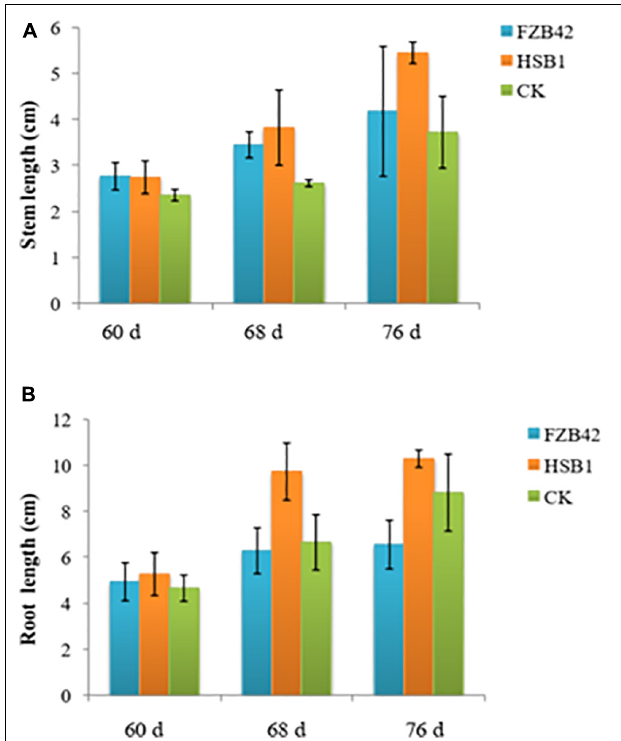
FIGURE 3 | Bar graphs showing changes in stem length (A) , and root length (B) of wolfberry seedlings whose soil was treated with Bacillus amyloliquefaciens strains (FZB42 or HSB1) compared to a water control (CK). Measurement time points are based on growth at 60, 68, and 76 day. Error bars represent standard deviation of three